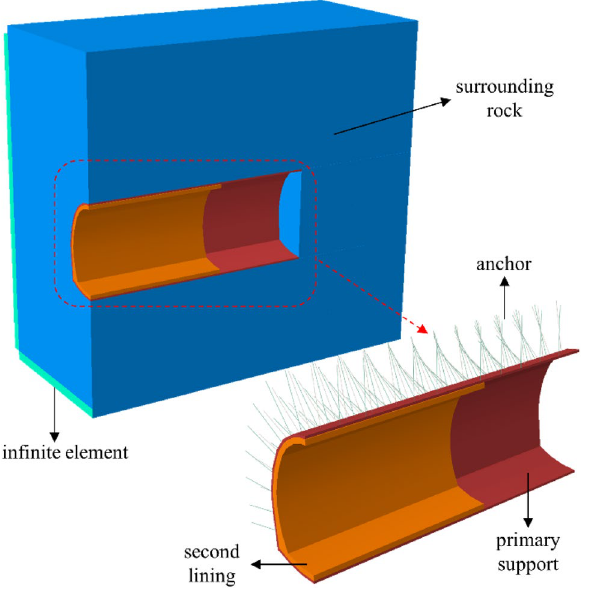
Figure 9. Schematic of numerical model.